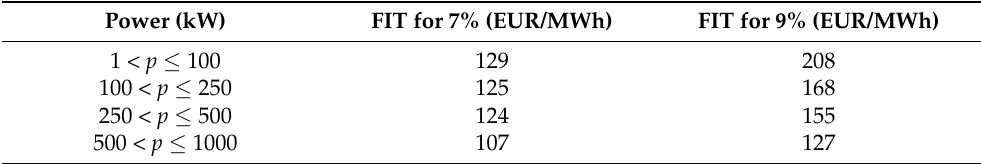
Table 5. Remodeling of the tariff